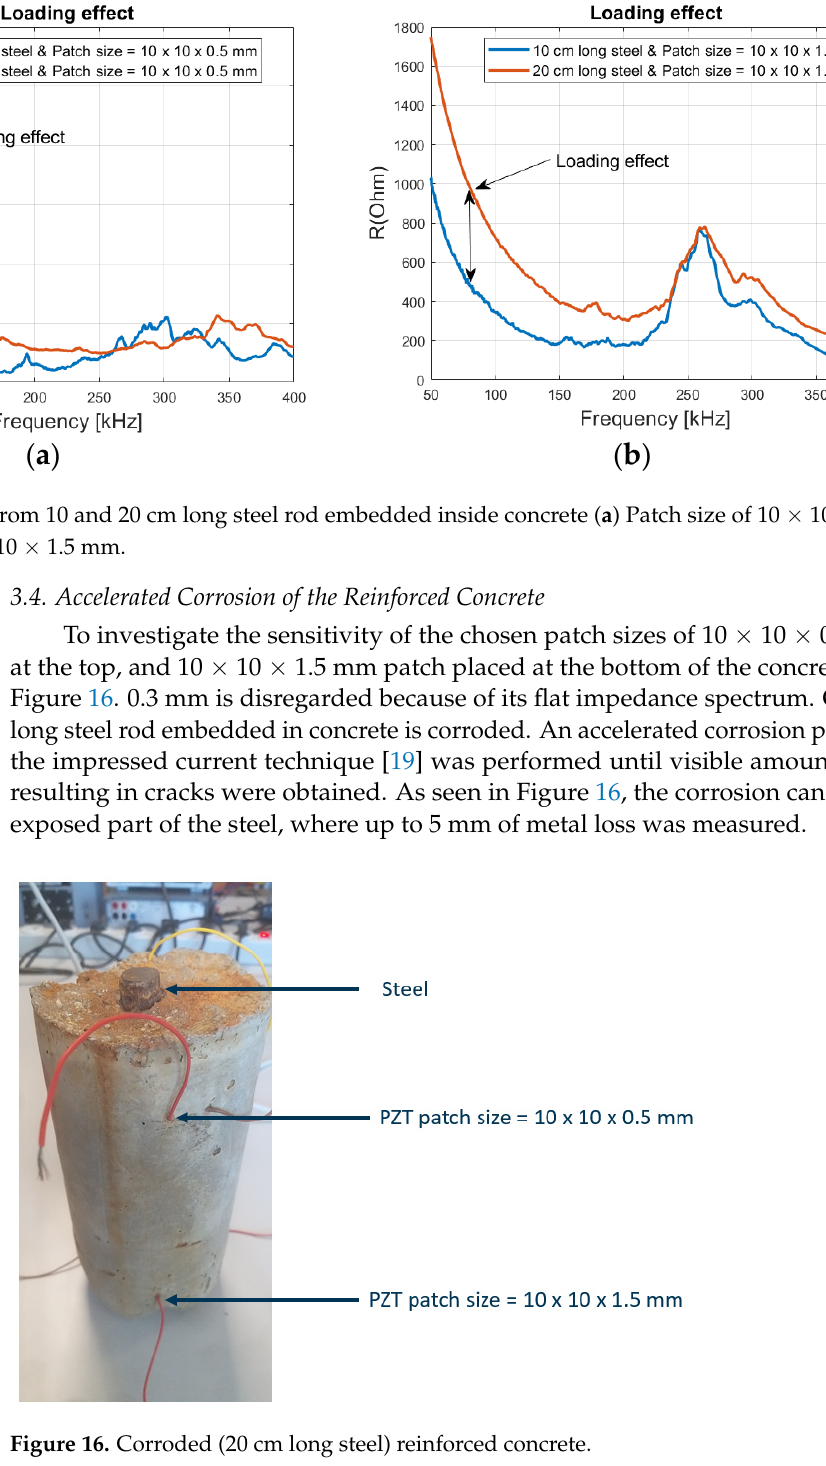
Figure 16. Corroded (20 cm long steel) reinforced concrete.